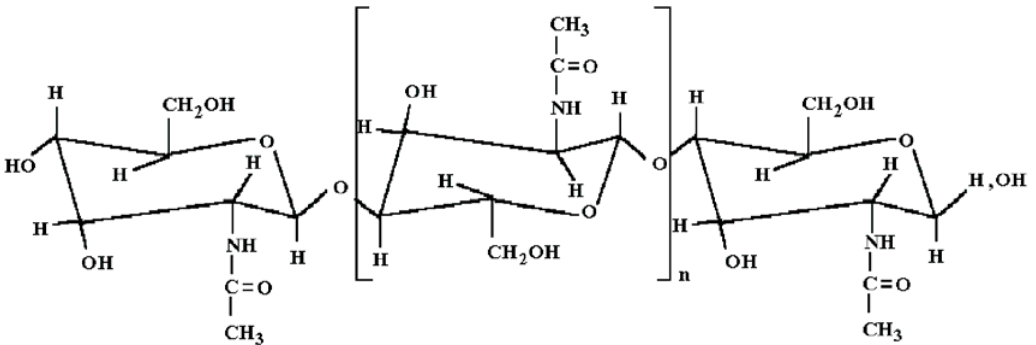
Figure 2. Chemical structure of